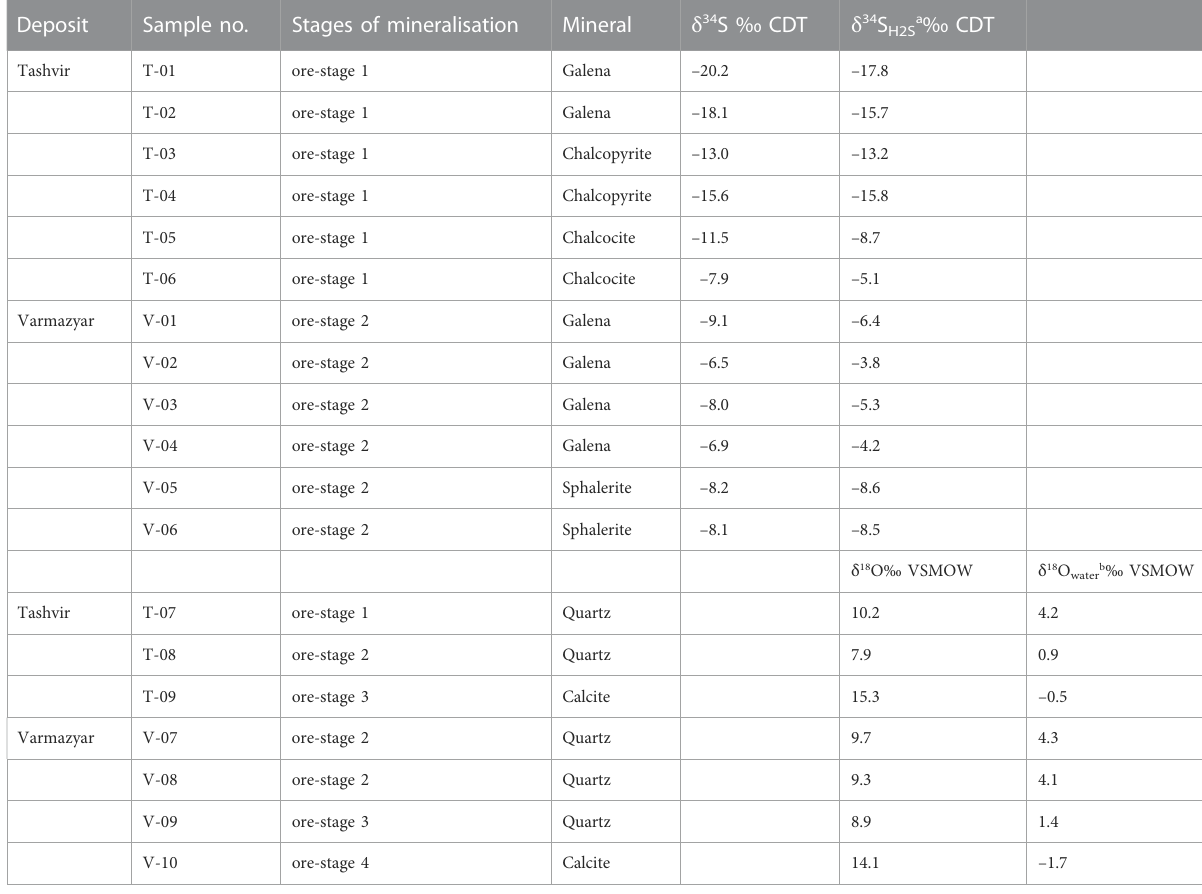
TABLE 3 Sulfur and oxygen isotope data for the Tashvir and Varmazyar deposits. Deposit Sample